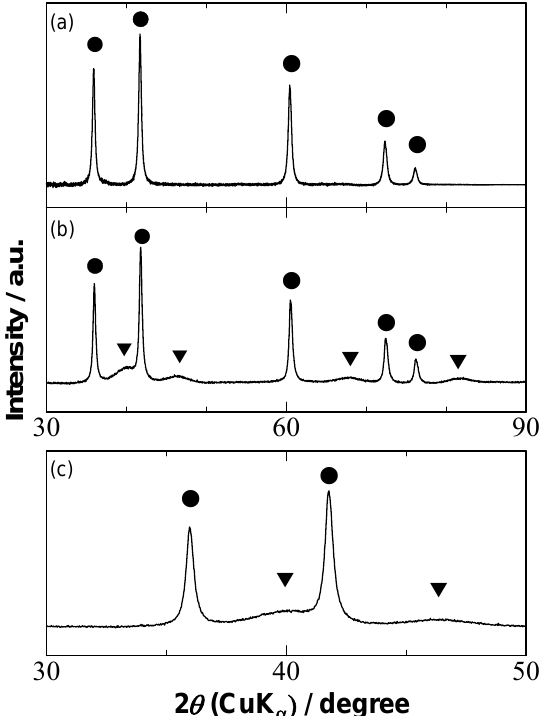
Figure 1. X-ray diffraction patterns for ( a ) Pt/TiC as-prepared and ( b ) ( c ) heat-treated at 600 °C (Pt/TiC-600 °C). The panel ( c ) is the enlarged XRD pattern from 30° to 50° for Pt/TiC-600 °C. The assignment of peaks is shown by ( ● ) cubic TiC and ( ▼ ) Pt. The peaks in ( a ) from low diffraction angles to high angles correspond to the lattice distance of TiC (111), (200), (220), (311), and (222). The peaks in ( b ) marked with ▼ correspond to the lattice distance of Pt (111), (200), (220), and (311) from low diffraction angle to high angle,